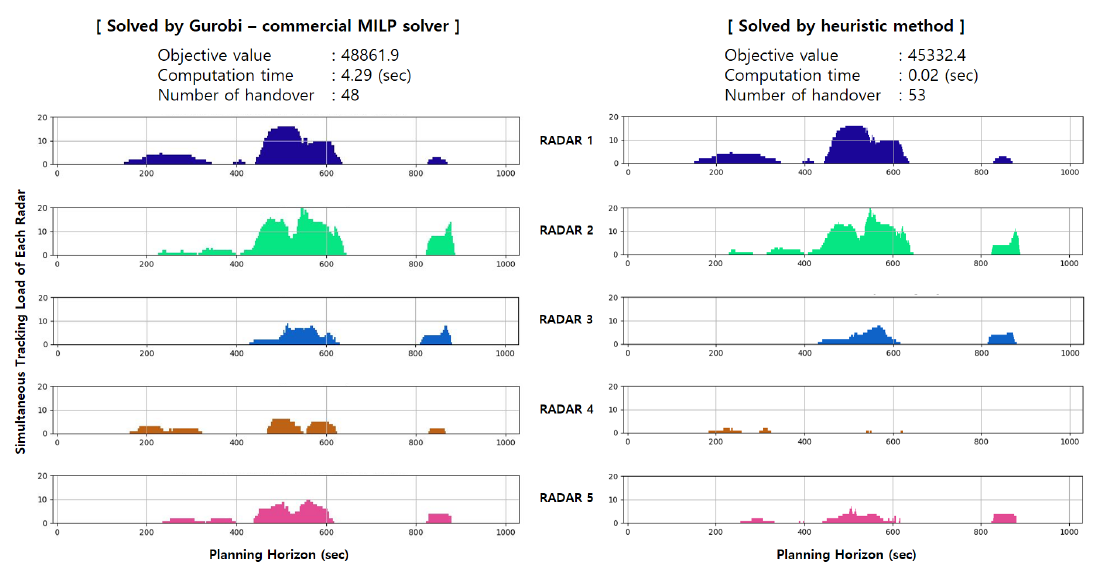
Figure 14. Simulation result comparison in the sense of the Number of simultaneously tracked target for each